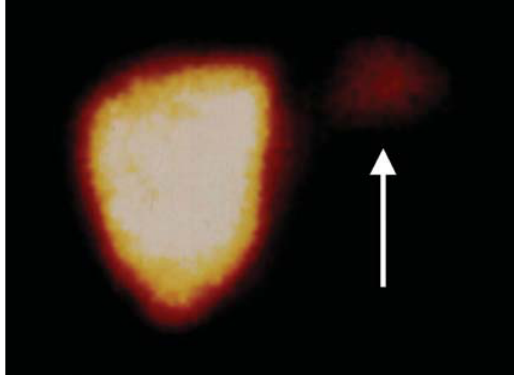
Figure 3 - Scintigraphic images (using 99m Tc sulfur colloid) of a splenic remnant (arrow) after subtotal splenectomy for portal